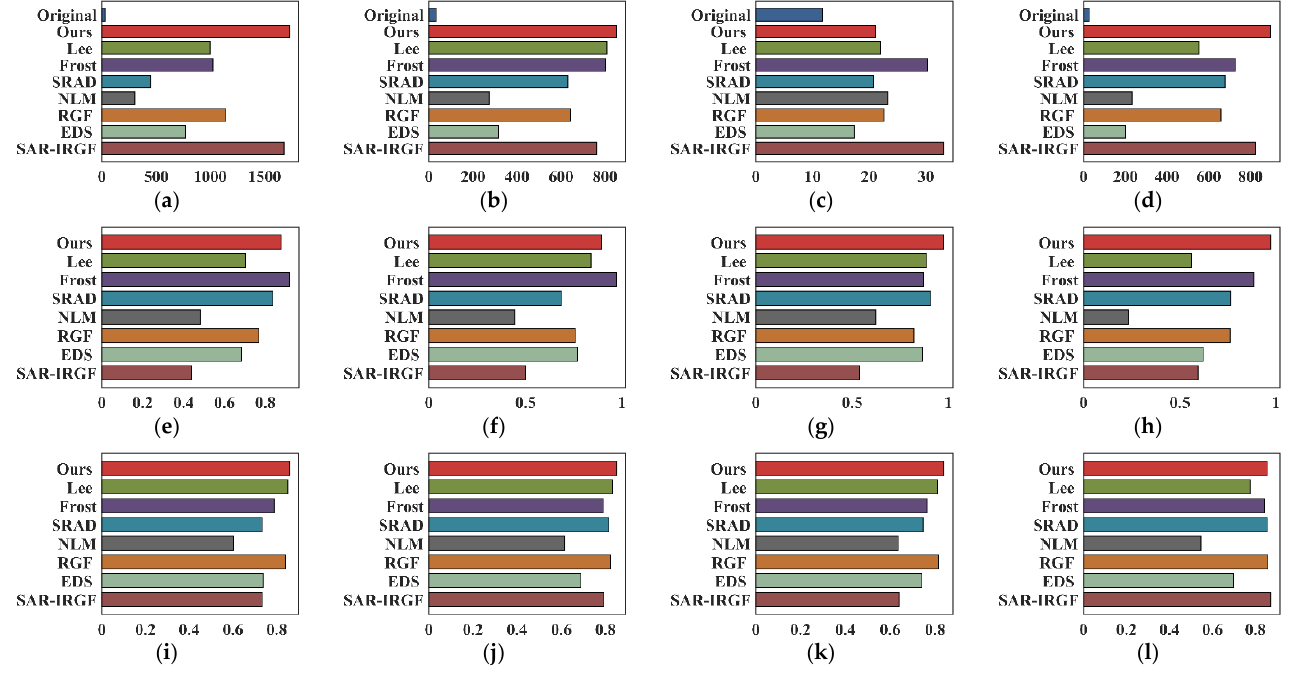
Figure 16. ENL, EPI, and SSIM results for the speckle suppression on four optical images : ( a – d ) are the ENL comparison results for the plant, clamps, the keyboard, and the apple, respec- tively. Similarly, ( e – h ) are their corresponding EPI results, while ( i – l ) are their SSIM